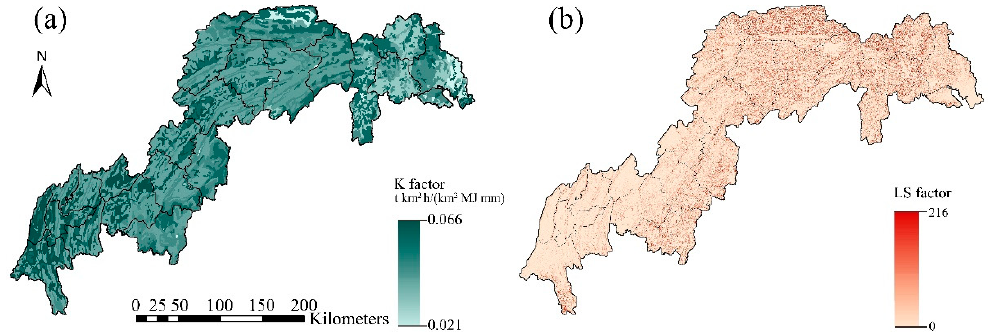
Figure 5. Estimated distributions of ( a ) soil erodibility, K factor; ( b ) slope length and steepness, LS factor.